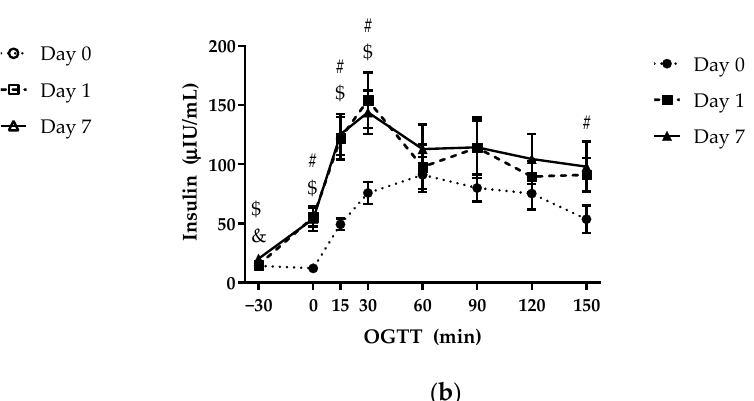
Figure 4. Mean (±SE) insulin concentrations in ( a ) CON ( n = 15) and ( b ) PCOS ( n = 14) across timepoints. * = significance between Day 0 and Day 1 for CON; ^ = significance between Day 0 and Day 7 for CON; # = significance between Day 0 and Day 1 for PCOS; $ = significance between Day 0 and Day 7 for PCOS; & = significance between Day 1 and Day 7 for PCOS, p < 0.05. CON = non-PCOS women; OGTT = oral glycemic tolerance test; PCOS = women with polycystic ovarian syndrome.